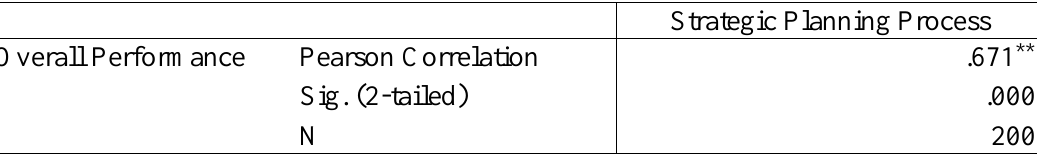
Table 5: Relationship between Strategic Planning Process and Business Performance